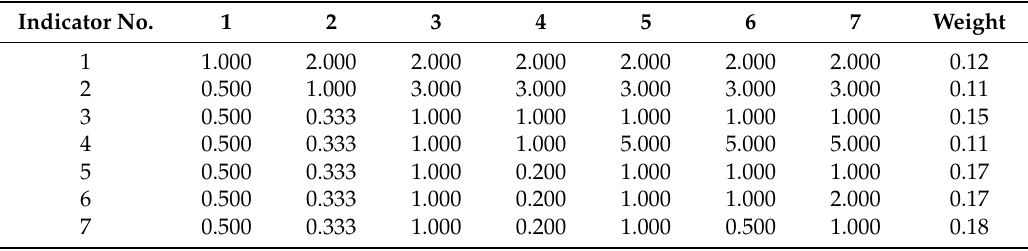
Table 2. Analytic Hierarchy Process (AHP) decision matrix and indicators